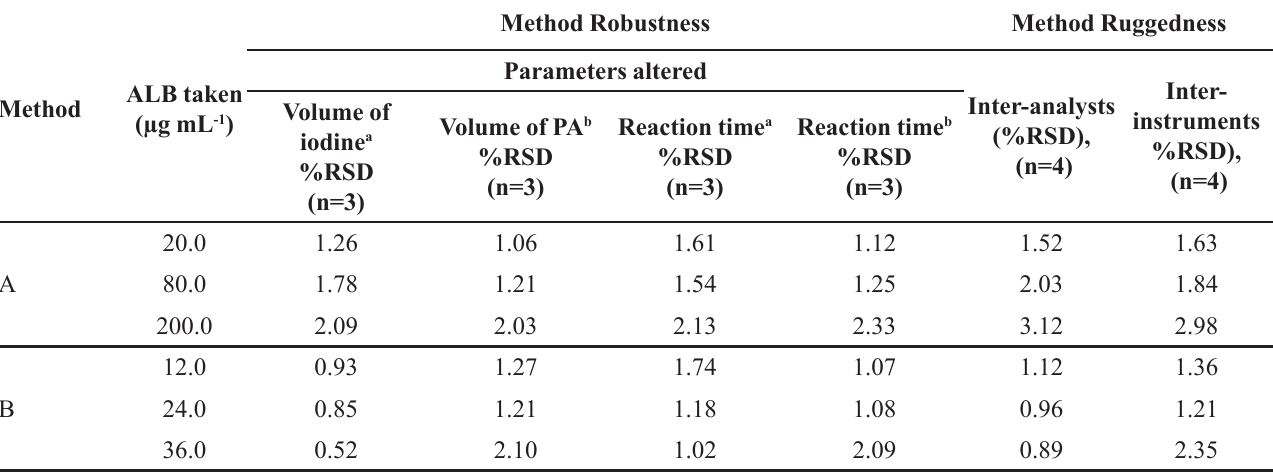
TABLE III - Method robustness and ruggedness expressed as intermediate precision